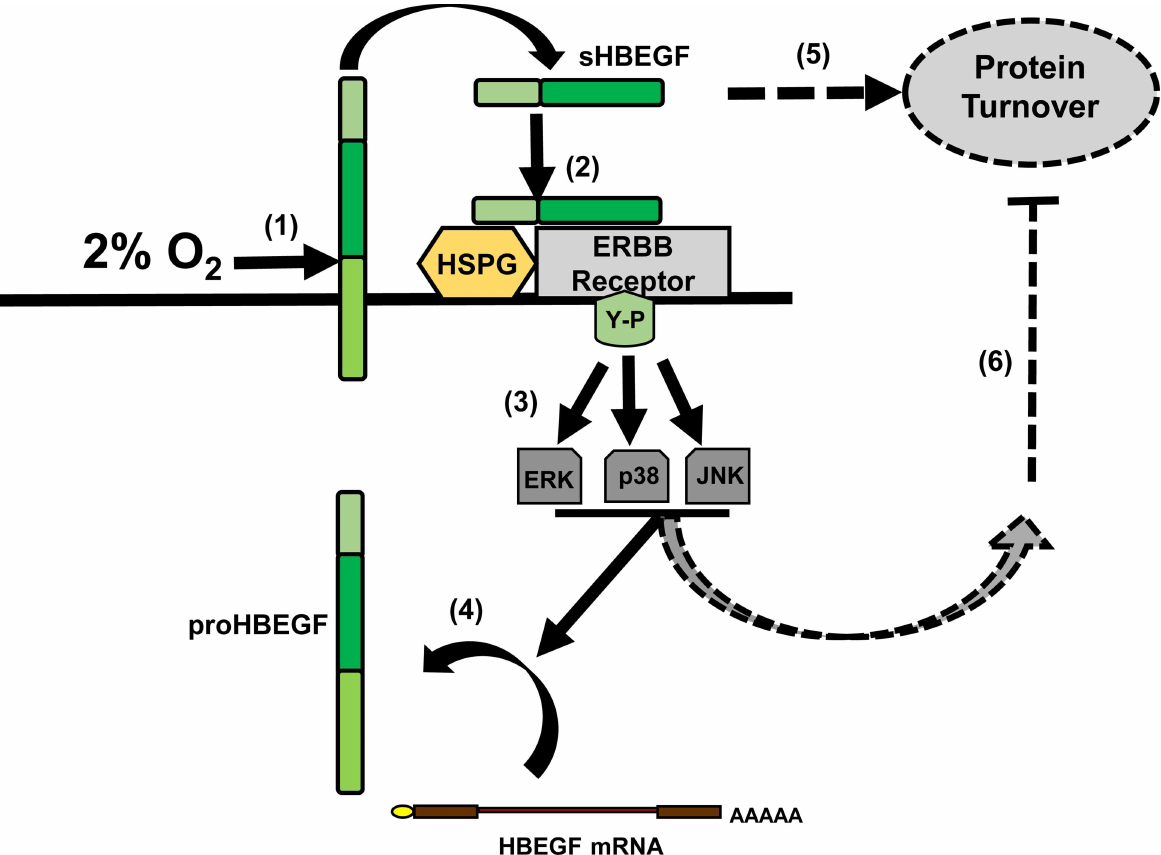
Fig 1. Regulation of HBEGF by downstream signaling in human TB cells. Low (2%) O 2 induces cleavageof the extracellular domain of proHBEGF (1). The releasedsHBEGF binds to ERBB receptors through its EGF-like domain and to heparansulfate proteoglycans (HSPG) through its heparin-binding domain (2). Subsequent transphosphorylationof HER cytoplasmic domains at key tyrosine (Y-P) residues (3) initiates MAPK (ERK, p38, JNK) signaling(4) that increasesHBEGF accumulationand inhibits apoptosis. This positive feedback loop achieves extracellular HBEGF levels sufficient to maintain TB cell survival at 2% O 2 . Alternatively, HBEGF protein turnover (5) could be inhibitedby downstream MAPKs signaling(6), to induce protein